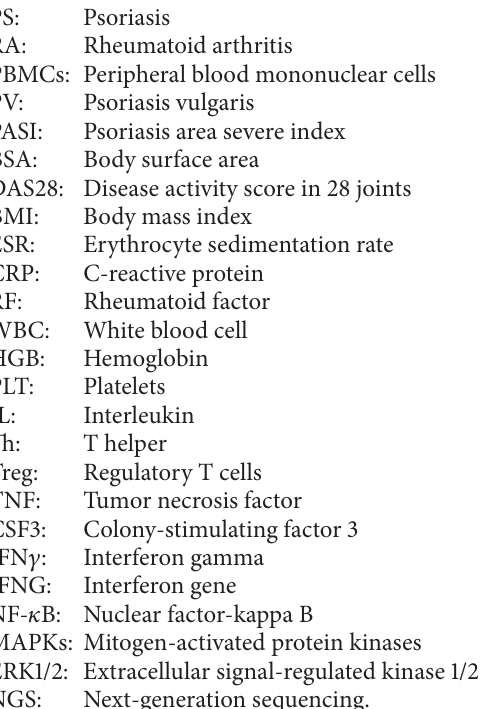
and p38 MAPK signaling, reflected this type of